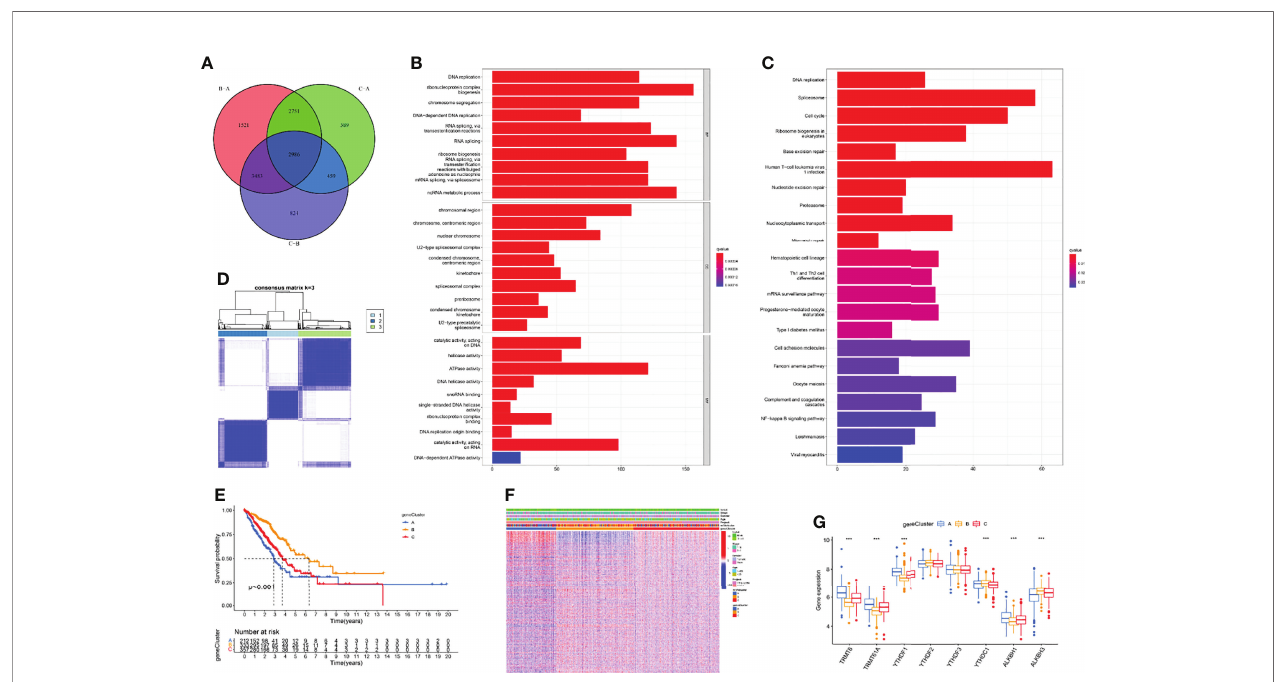
FIGURE 4 | Identi fi cation of three m1A gene clusters. (A) 2986 DEGs of three m1A modi fi cation patterns were shown by Venn diagram. (B, C) GO and KEGG results revealed the potential function of 1787 prognosis-related DEGs. (D) Consensus clustering of m1A gene clusters for LUAD patients in the training cohort. (E) Survival outcome prediction of three m1A gene clusters in the training cohort. (F) Heatmap of consensus clustering of 1787 prognosis-related DEGs. (G) The different expression levels of m1A regulators in three m1A gene clusters (***P <